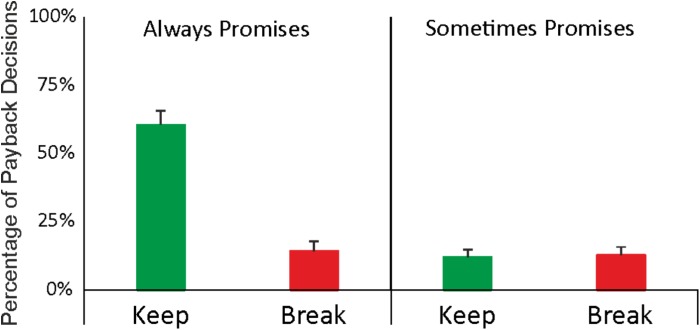
Average percentages of keep (green bars) and break (red bars) decisions as a function of promise decisions (“ALWAYS” vs. “SOMETIMES”). Overall, 75% of the promise decisions were “ALWAYS” decisions whereas 25% were “SOMETIMES” decisions.